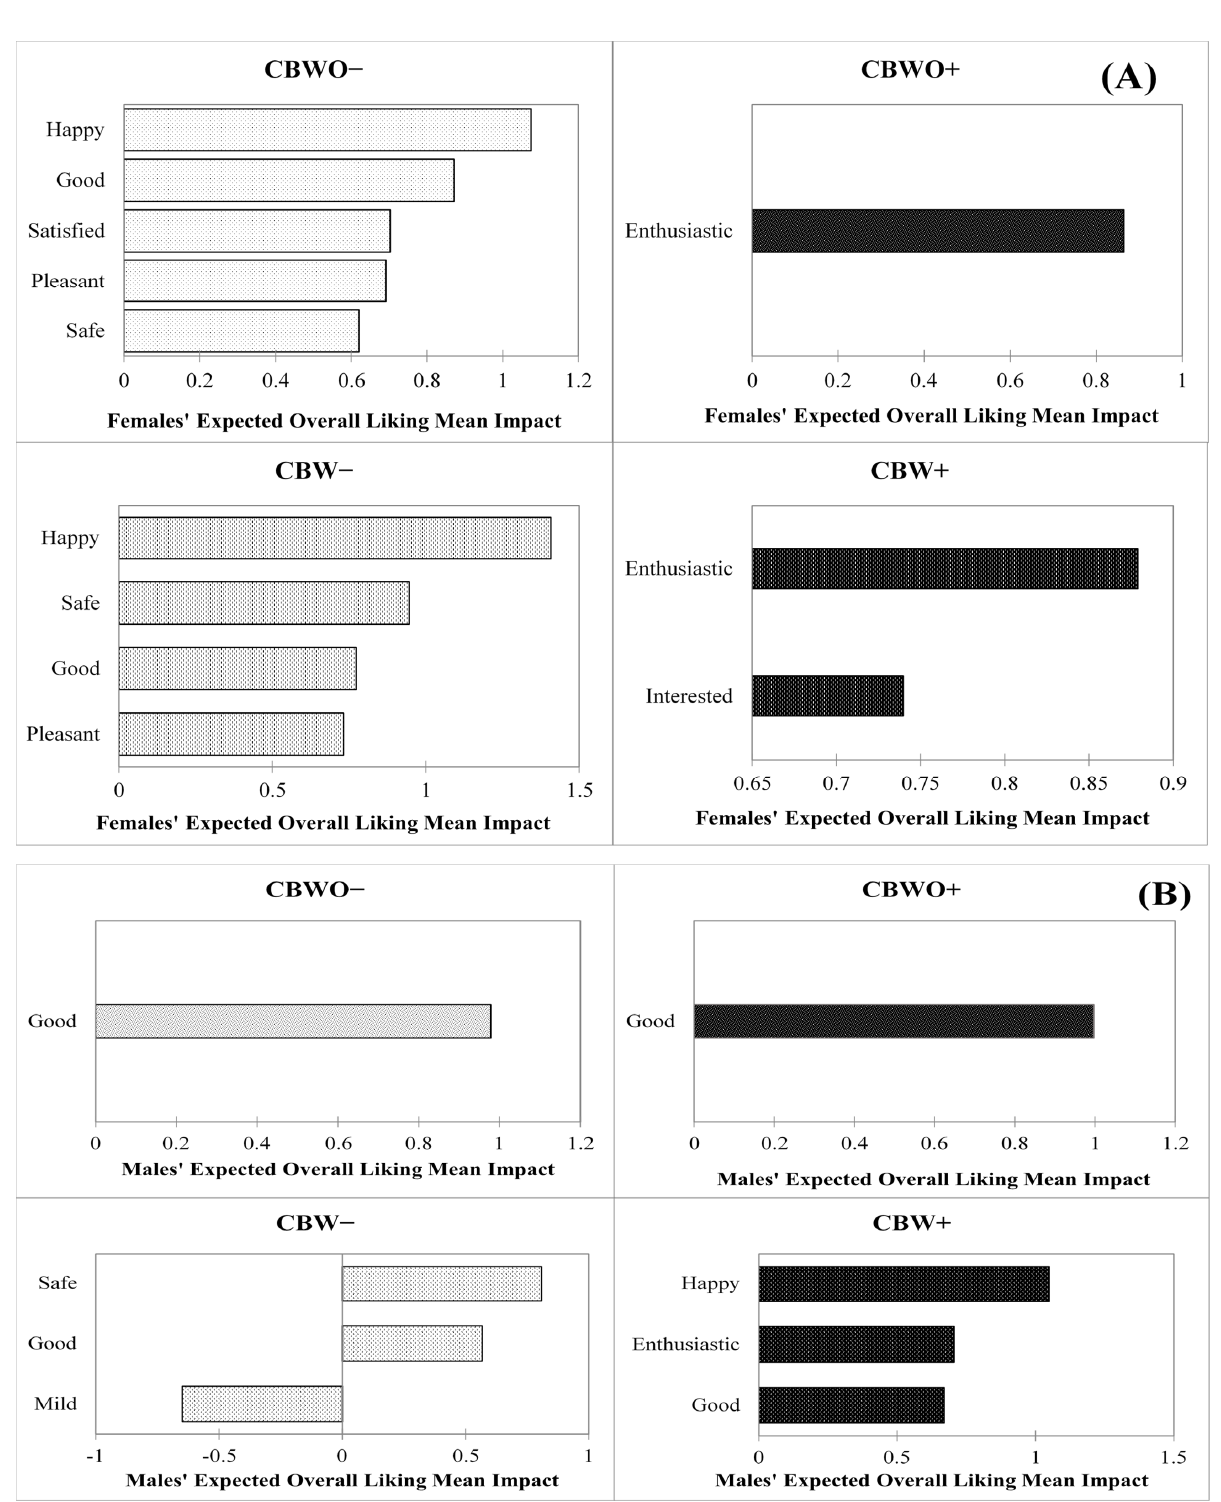
Figure 5. Treatments before-tasting overall liking (OL) mean impact (mean OL difference from present vs. absent categories for each emotion with a 20% population threshold size) vs. significant ( p < 0.05, 2-sample t -test) emotions in the before-tasting condition (%) for ( A ) female ( n = 112) and ( B ) male ( n = 98) groups. Treatments are described in Figure